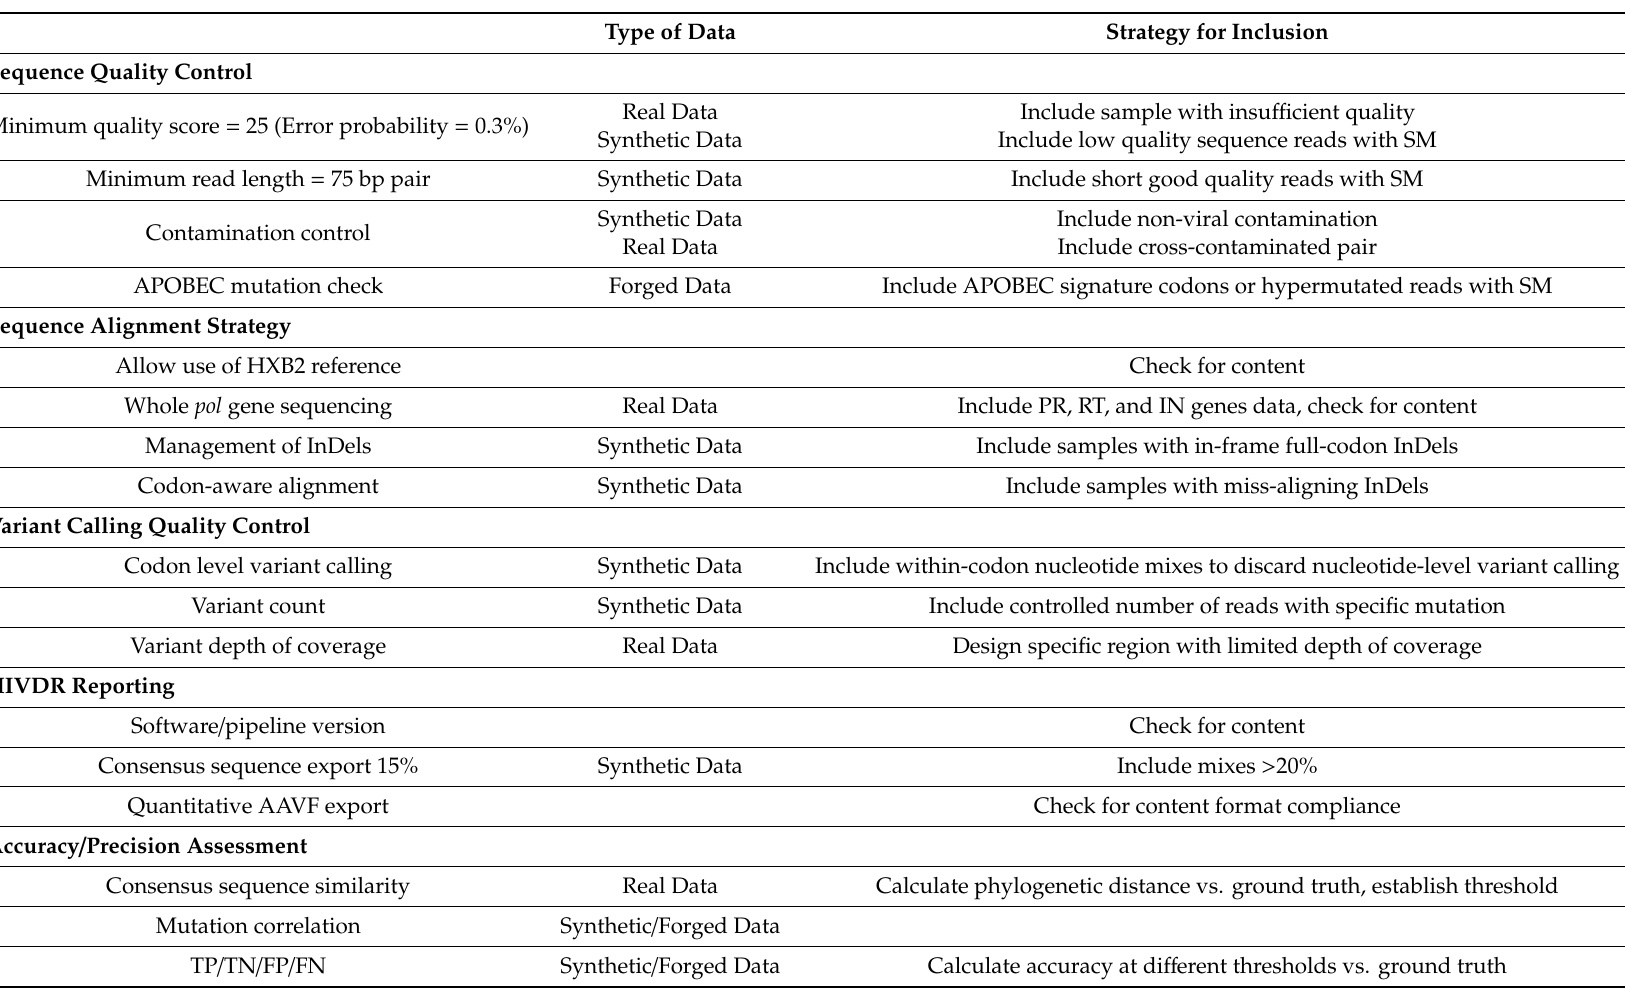
Table 1. Specific dataset and software features to be included and validated by next generation sequencing (NGS) HIV drug resistance testing (DRT) dry